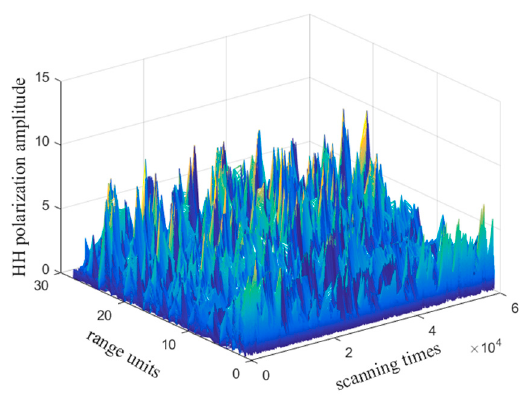
Figure 4. Partial IPIX sea clutter 3D map of HH polarization.